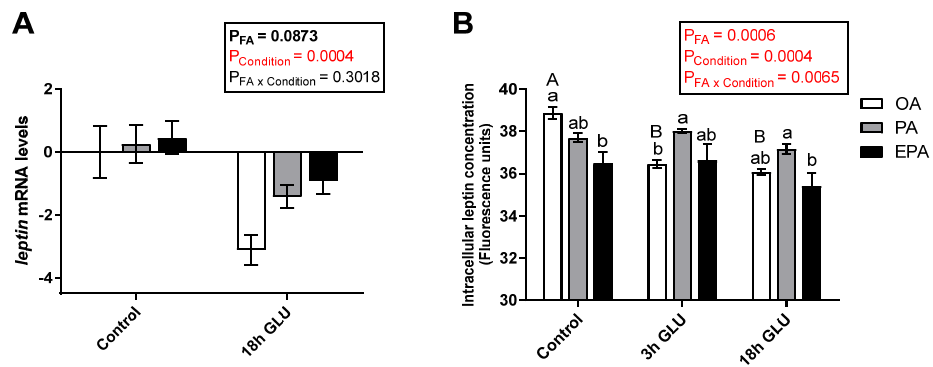
Figure 3. ( A ) Relative changes in transcript levels of leptin in mature Atlantic salmon adipocytes incubated with oleic, palmitic, or eicosapentaenoic acid for 72 h (Control) and serum-deprived in the presence of glucagon thereafter for 18 h (18h GLU). Data are shown as mean ± SEM ( n = 4). Results are compared by two-way ANOVA using the fatty acid tested (OA, PA, and EPA) and the experimental condition (Control and 18h GLU) as factors. ( B ) Changes in intracellular leptin concentrations